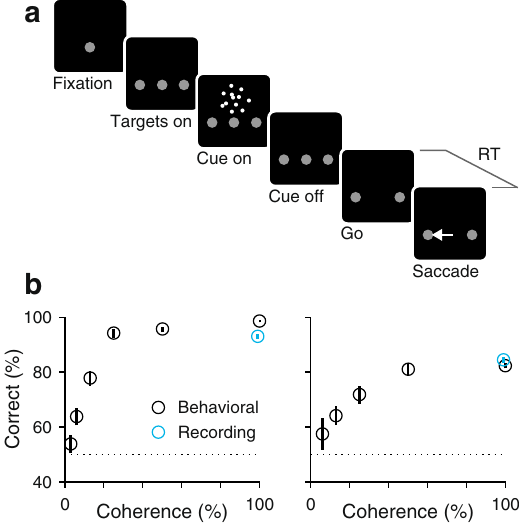
stimulus follows (Cue on) after anunpredictabledelay period between them (Gap, 0 – 250). The RT time window for responding is limited (350 – 425 ms), so the per- ceptual evaluation must occur as the motor plan develops. The likelihood of suc- cess is dictated by the processing time interval (rPT=RT − gap), which is when the motioncueisvisible.Graylinesmarkintervals(RT,Gap,rPT)betweenevents(black squares). d Performance in the CRDM task as a function of rPT, or tachometric curve. Results are from behavioral sessions from monkeys C (left) and T (right) for 100% (red; C: 9544, T: 33,971 trials) and a lower coherence (black; C: 7,909, T: 12,066 trials). Each point includes trials within a 51 ms rPT bin. Traces show per- centage of correct choices across trials in each bin, and shaded error bands indi- cate±1 SE. Source data are provided as a Source Data fi